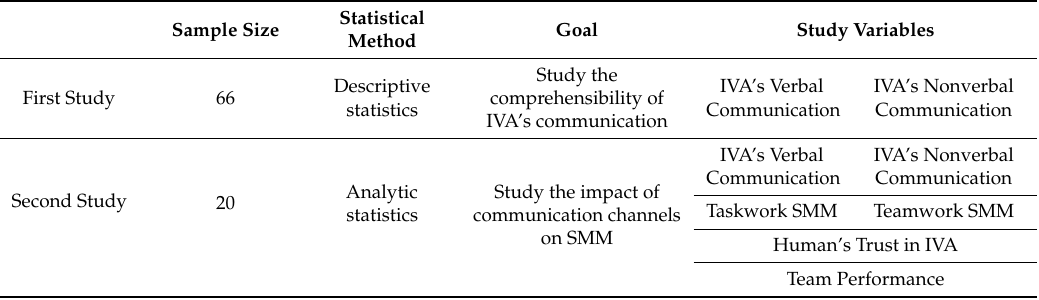
Table 1. Description of sample size, statistical method goal, and variables of the two